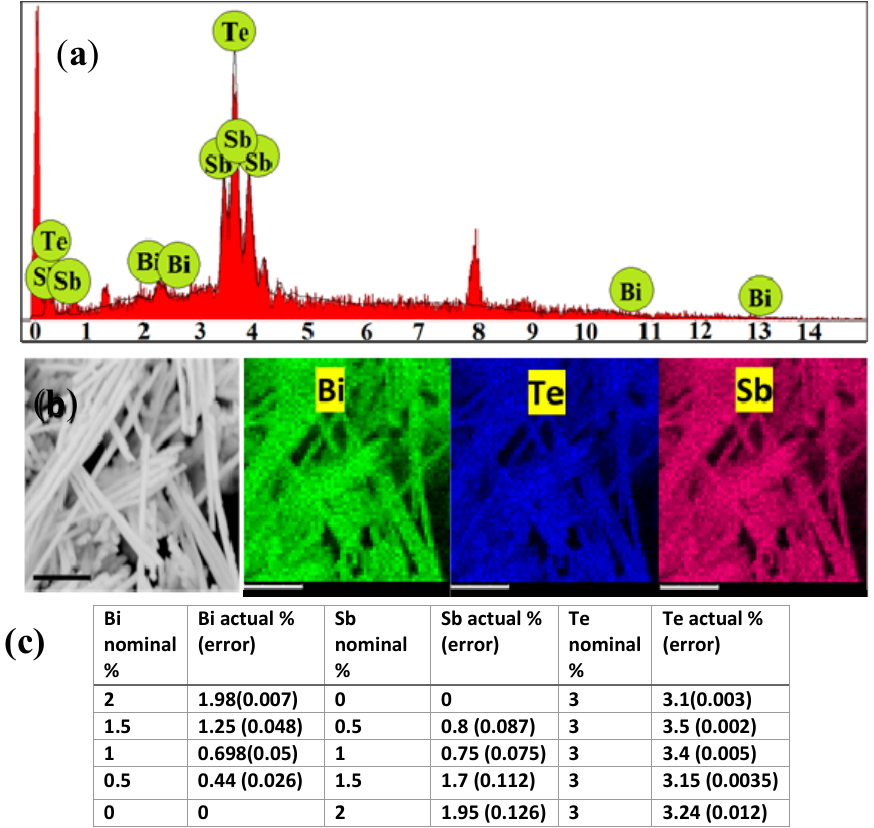
Figure 2. ( a ) Representative EDX spectrum of Bi 2 − x Sb x Te 3 NWs; ( b ) Mapping of the Bi 2 − x Sb x Te 3 NWs reveal uniform presence of the constituent elements: bismuth (green), tellurium (blue) and antimony (pink). The scale bar in the mapping indicates 1 μ m; ( c ) Table showing the nominal atomic % of Bi, Sb and Te elements and the actual atomic % of the same elements present in the samples, which reveal that the samples are slightly rich in tellurium. Tellurium may be present in metallic form within the samples.